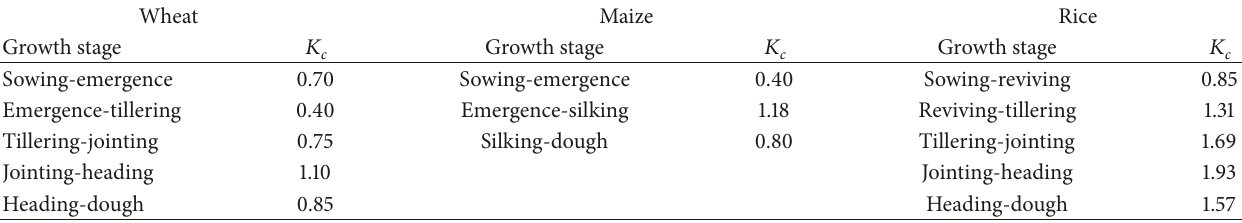
Table 2: Crop coefficient in each growth stage [32].